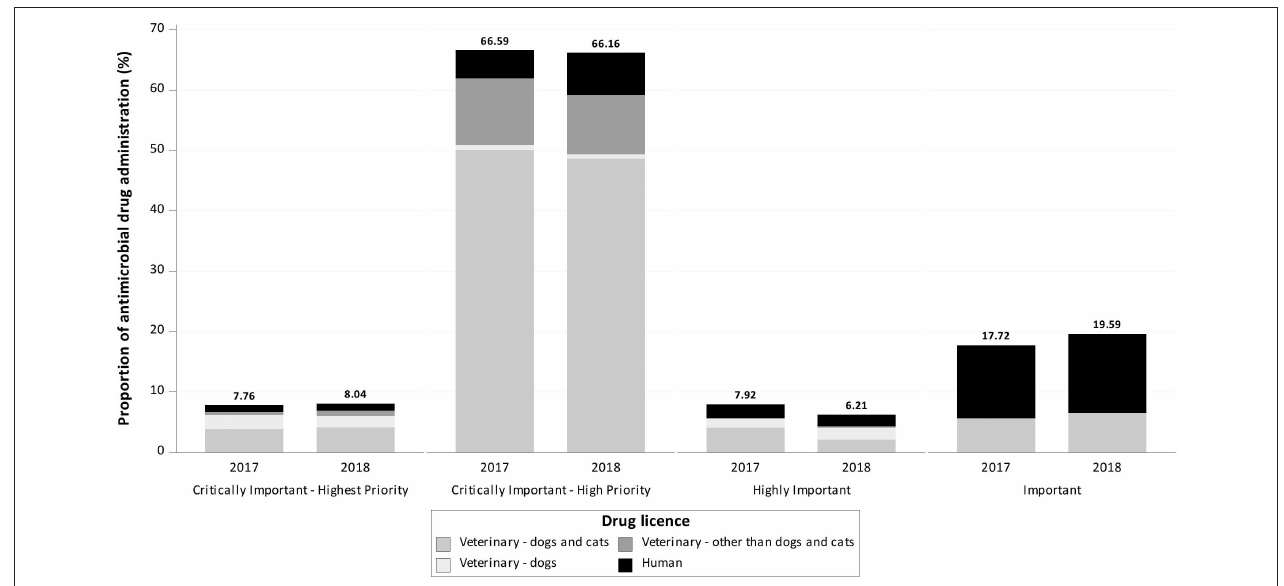
FIGURE 3 | Proportion of documented antimicrobial drug administrations reported to be used in cats in 2017 and 2018 at the Department of Small Animal Medicine and Surgery, University of Veterinary Medicine Hannover, by drug license type and World Health Organization